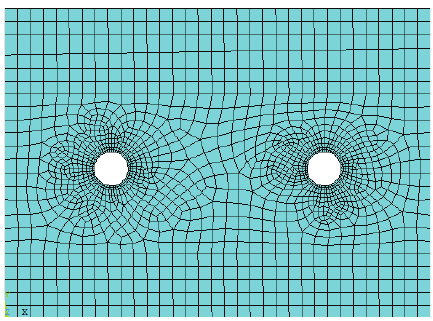
Figure 8: Finite element mesh for pipe spacing 150 mm at a depth of 75